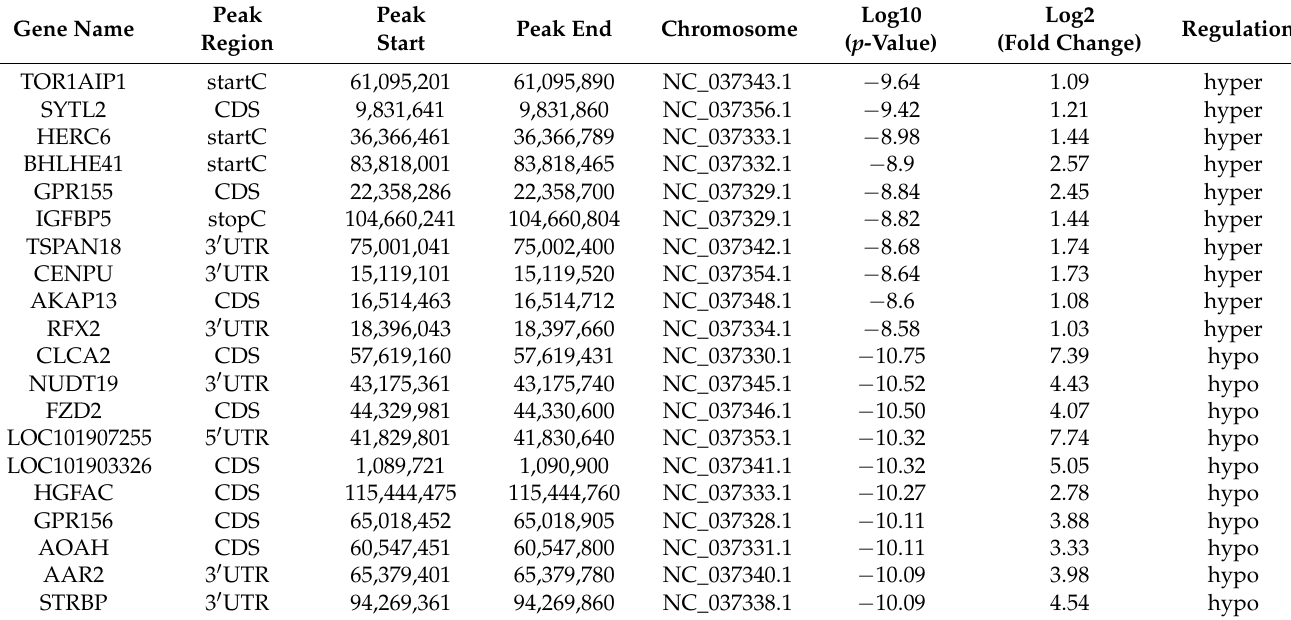
Table 1. The top 20 differently expresses m 6 A peaks between E. coli and controls based on p